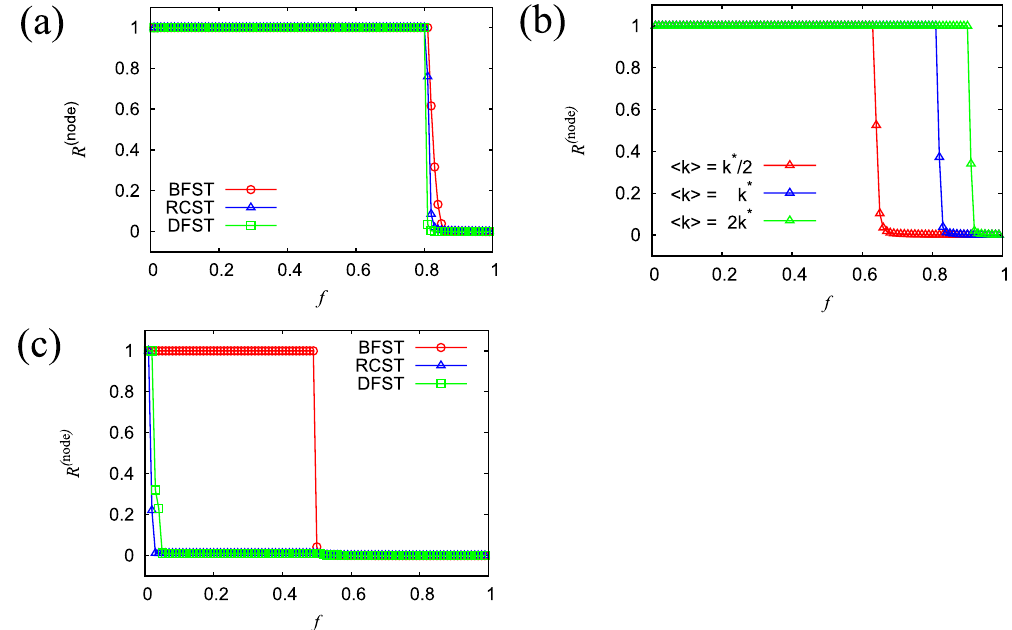
Figure 2. ( a ) Change in the largest cluster size R (node) in a business relations network from Japan. BFST (red circle), RCST (blue triangles) and DFST (green squares). Each plot represents the average of 100 trials. ( b ) Change in the largest cluster size R (node) in an Erdős-Rényi network. The average degree of connectivity 〈 k 〉 is represented by k * /2 (red triangles), k * (blue triangles), and 2 k * (green triangles), where k * is the average degree for the business relations network. Each plot represents the average of 10 trials. ( c ) Change in the largest cluster size R (node) in an extended ring network. BFST (red circle), RCST (blue triangles) and DFST (green squares). Each plot represents the average of 10 trials.